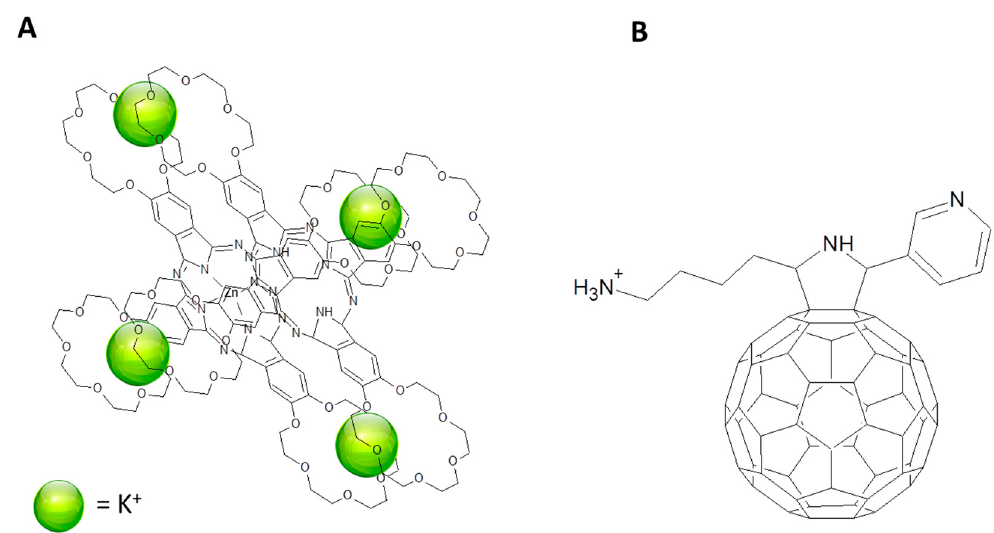
Figure 14. ( A ) ZnPcs derivative sandwich formed by the action of K + . ( B ) C60 derivative used to form the triad with ( A ) according to [97].